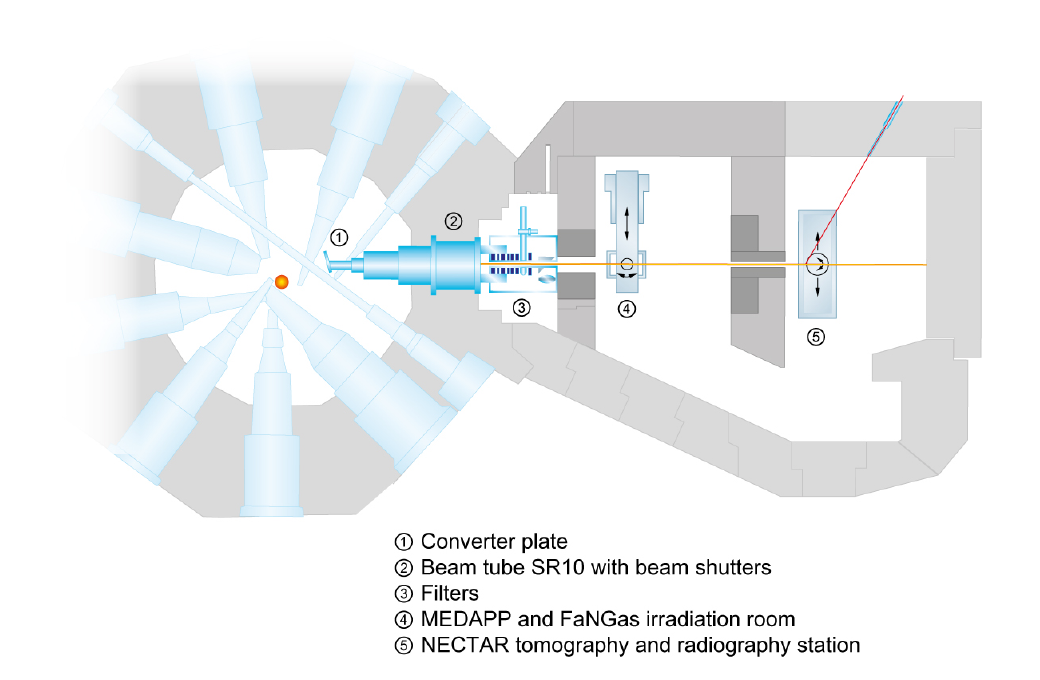
Figure 2: Schematic drawing of NECTAR and MEDAPP (Heinz Maier-Leibnitz Zentrum,